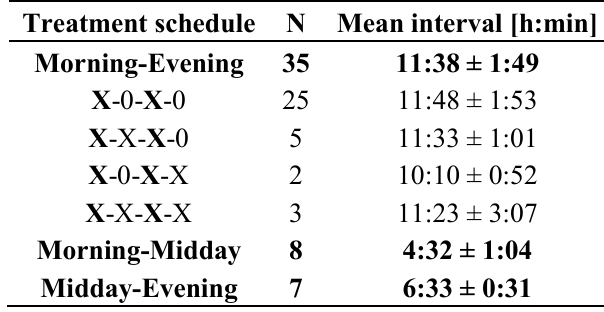
Table 3. Intervals between doses (mean ± SD) for 35 patients with morning-evening schedules (data of three patients were excluded from the calculation due to incomplete